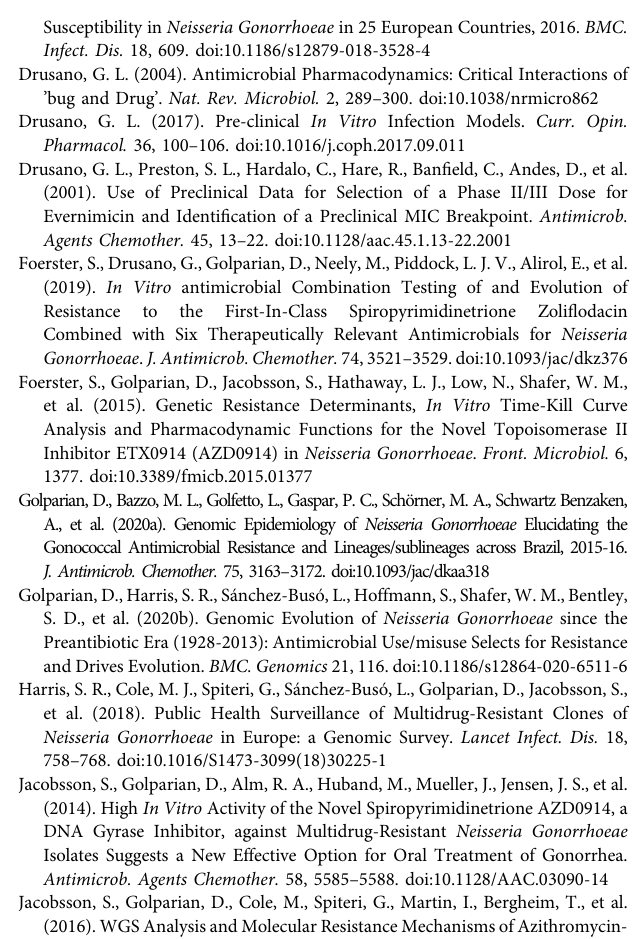
Supplementary Figure 1 | Schematic fl ow chart summarizing the main experiments of the zoli fl odacin-susceptible Neisseria gonorrhoeae SE600/18 parent strain (with a GyrB S467N mutation) and the zoli fl odacin-resistant N. gonorrhoeae SE600/18-D429N mutant (with GyrB S467N plus GyrB D429N selected in the Hollow Fiber Infection Model (HFIM)). Supplementary Figure 2 | Predicted-Observed regressions for zoli fl odacin concentrations, total Neisseria burden and resistant bacterial burden, respectively for the pre-Bayesian regression (A – C) and for the Bayesian regressions (D – F) for the clinical zoli fl odacin-susceptible Neisseria gonorrhoeae SE600/18 strain with a GyrB S467N amino acid